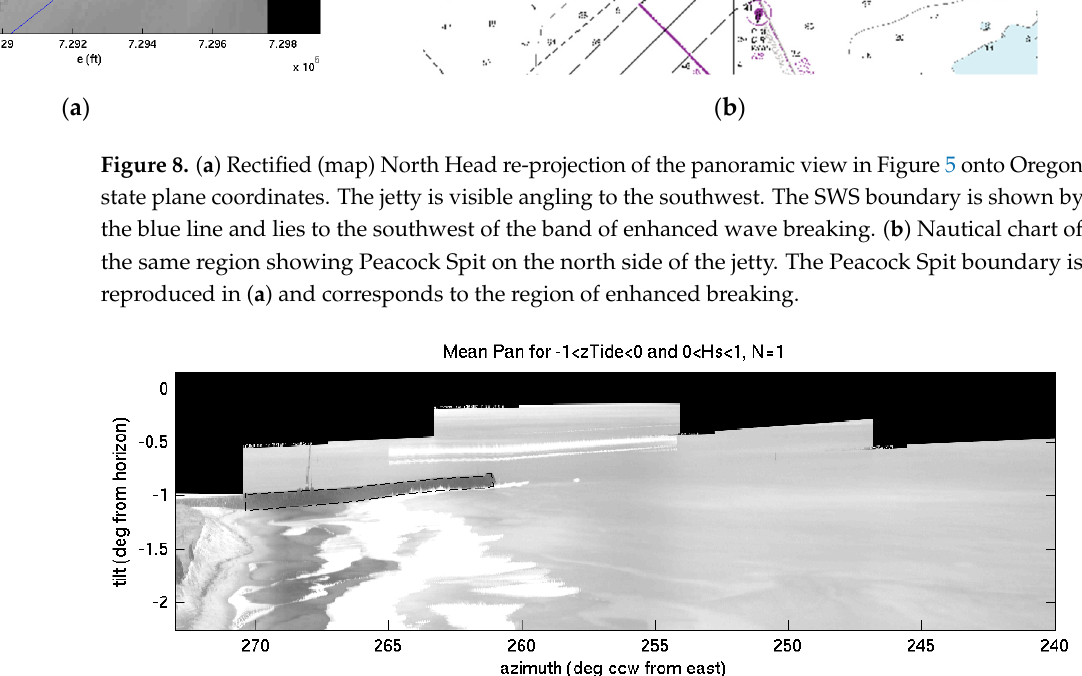
Figure 8. ( a ) Rectified (map) North Head re-projection of the panoramic view in Figure 5 onto Ore- gon state plane coordinates. The jetty is visible angling to the southwest. The SWS boundary is shown by the blue line and lies to the southwest of the band of enhanced wave breaking. ( b ) Nau- tical chart of the same region showing Peacock Spit on the north side of the jetty. The Peacock Spit boundary is reproduced in ( a ) and corresponds to the region of enhanced breaking.